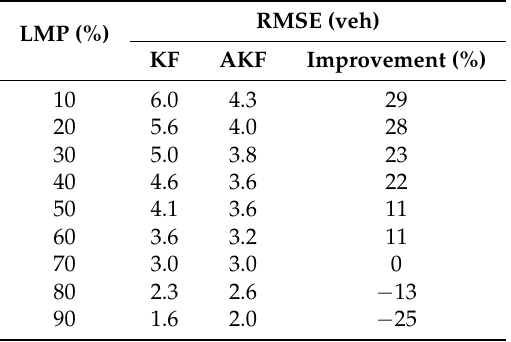
Table 2. Root mean square error (RMSE) values using the Kalman filter (KF) and the adaptive Kalman filter (AKF) models.